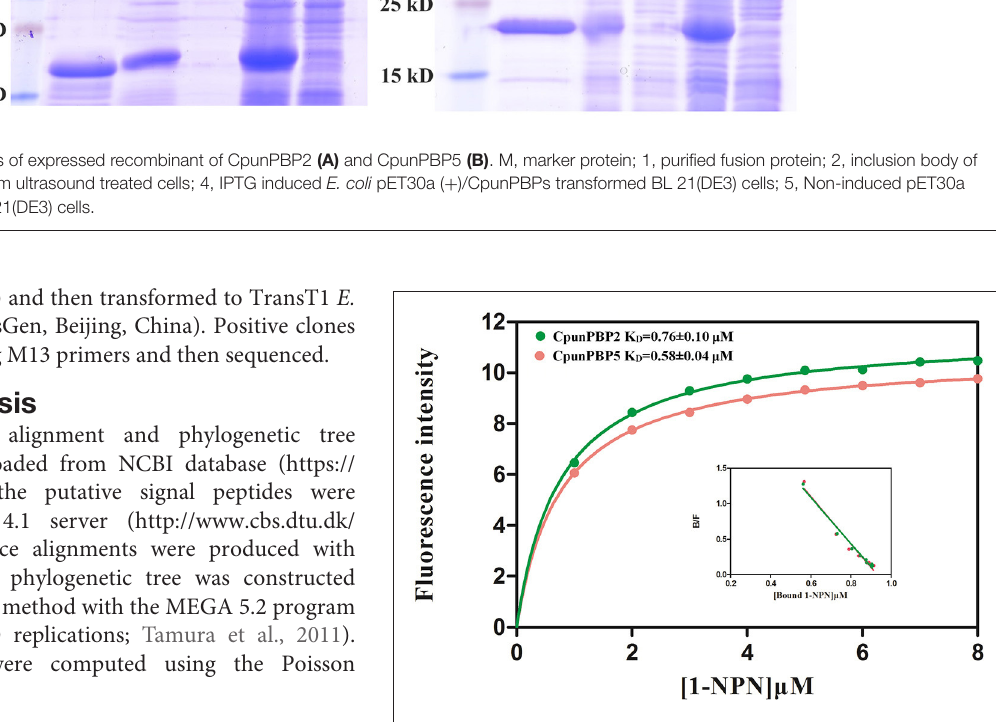
FIGURE 2 | The binding curve and relative Scatchard plots of 1-NPN with CpunPBP2 and